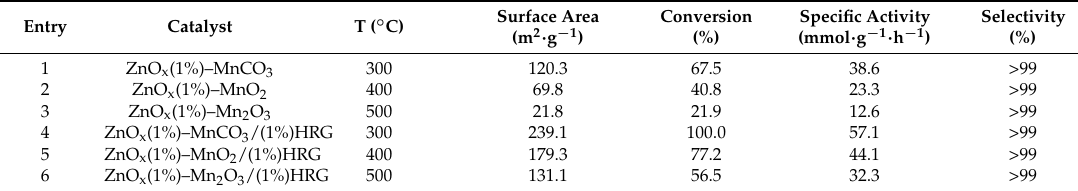
Table 3. Effect of the calcination temperature on the catalytic